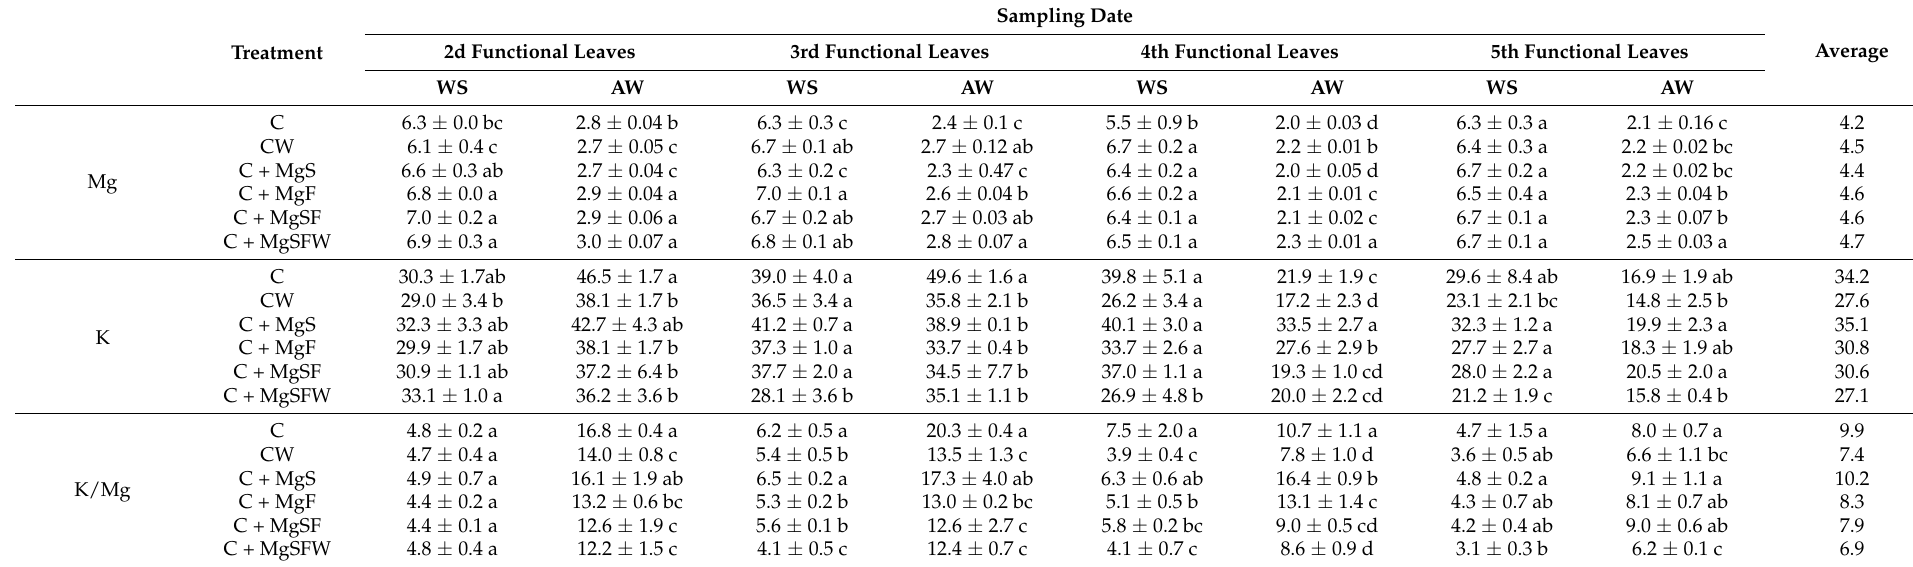
Table 2. The Mg and K contents (g kg − 1 ) and K/Mg ratio in functional leaves in two tomato seasons at different growth periods.